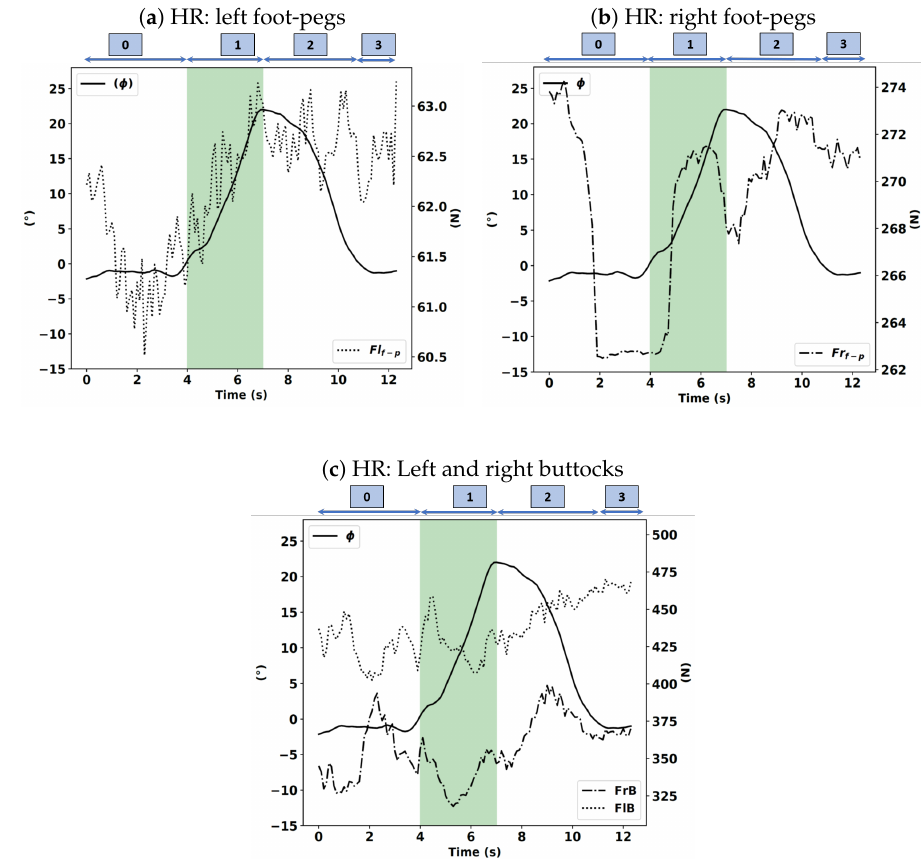
Figure 15. Left and right foot-pegs ( Fl f − p , Fr f − p ), buttocks forces ( FlB , FrB ) expressed in newtons (N) with the roll angle ( φ ) expressed in degrees (°) in the HR